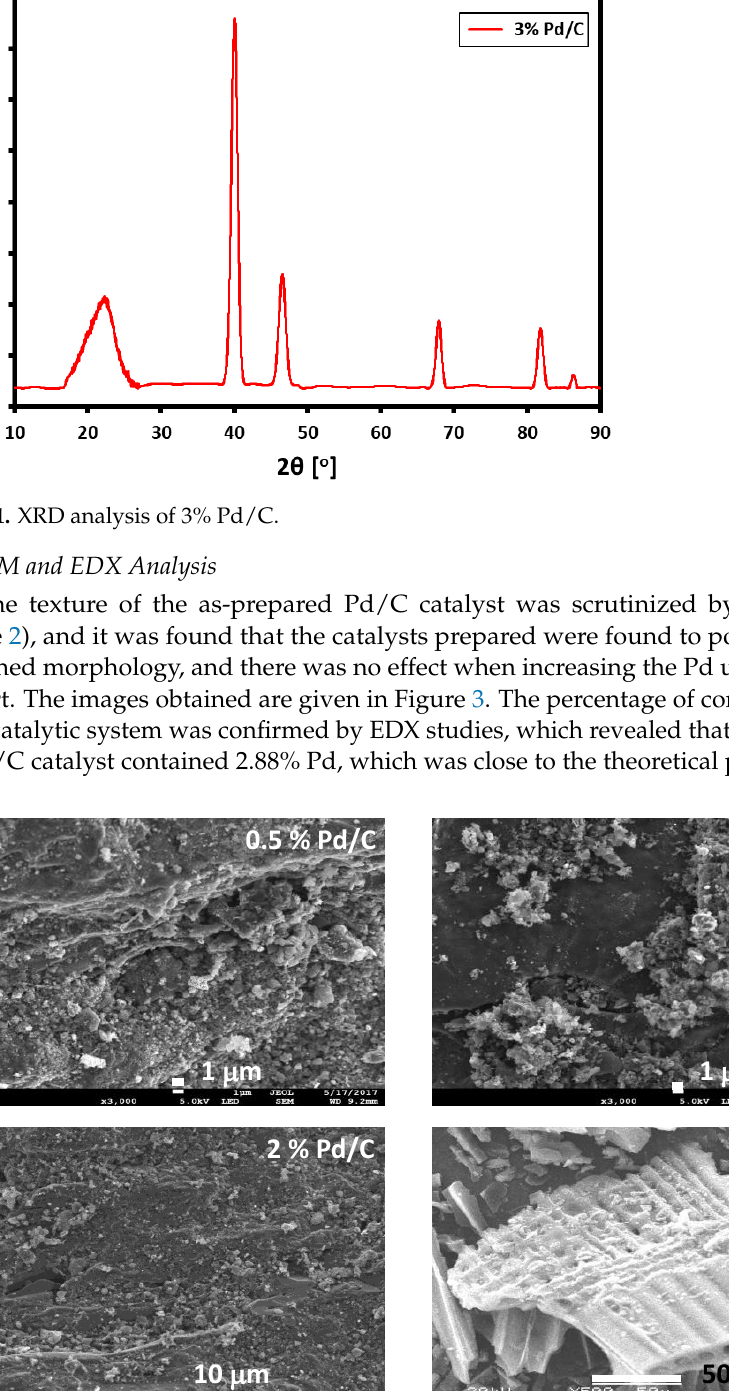
Figure 3. EDX analysis of 3% Pd/C. 3.3. BET Analysis The as-prepared Pd/C catalysts were studied to evaluate their adsorption profiles, and it was found that all the prepared materials exhibited that, with the increase in the percentage of Pd, the amount of N 2 adsorbed increased, indicating enhanced interacting sites with the increase in the Pd percentage (Figure 4). The pore size distribution obtained from the studies revealed that the pore sizes of the 0.5 – 2% catalysts were found to be in the range of 200 – 600 nm, and the pore volume obtained indicated that the pores were deep channels in the range of 0.07 – 0.08 cm 3 /g. The catalyst with 3% Pd/C was found to possess a pore size distribution of 25 – 150 nm, and the pore volume indicated the for- mation of shallow pores. Moreover, the BET surface areas of the samples increased with the increasing of Pd content; the 0.5%, 1%, 2% and 3% Pd demonstrated surface areas of 837, 838, 841 and 933 m 2 /g, respectively.